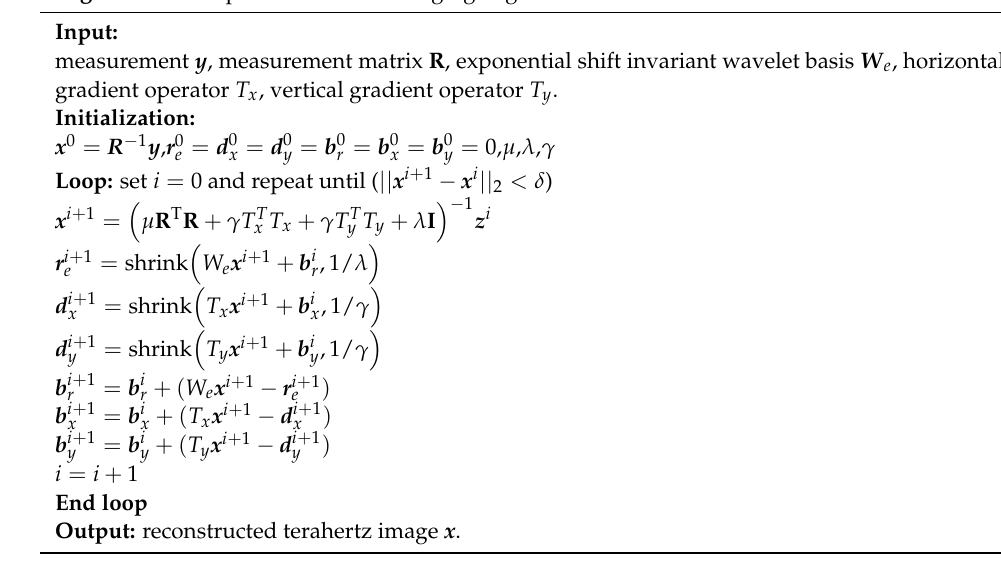
Algorithm 1. Proposed DSC-THz Imaging Algorithm